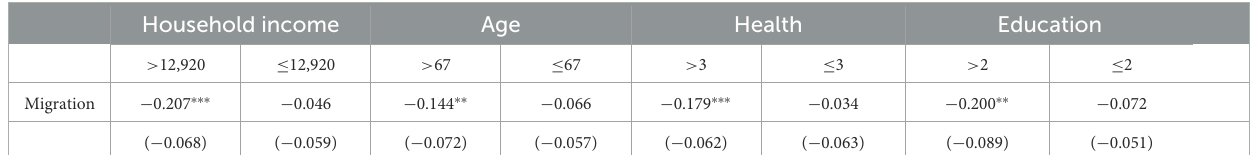
TABLE 6 Sub-sample regression results.